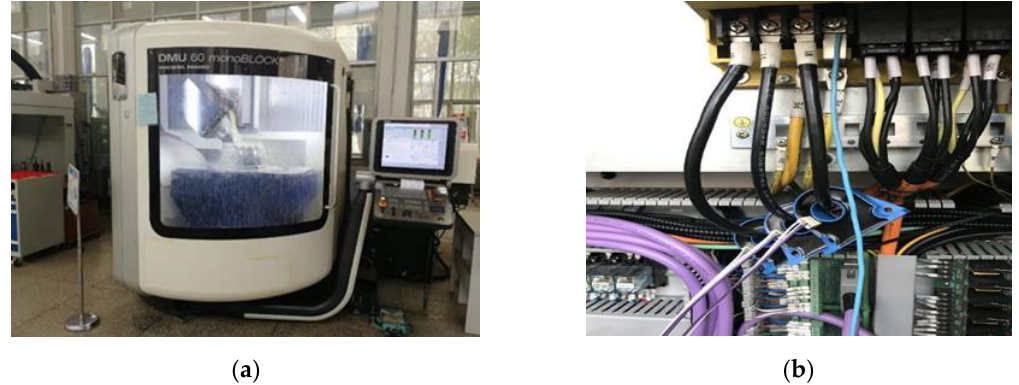
Figure 4. Experiment computerized numerical controlled (CNC) milling machine and the current sensor installation procedure: ( a ) the three-axis CNC milling machine; and ( b ) the Hall affect current sensor installation .